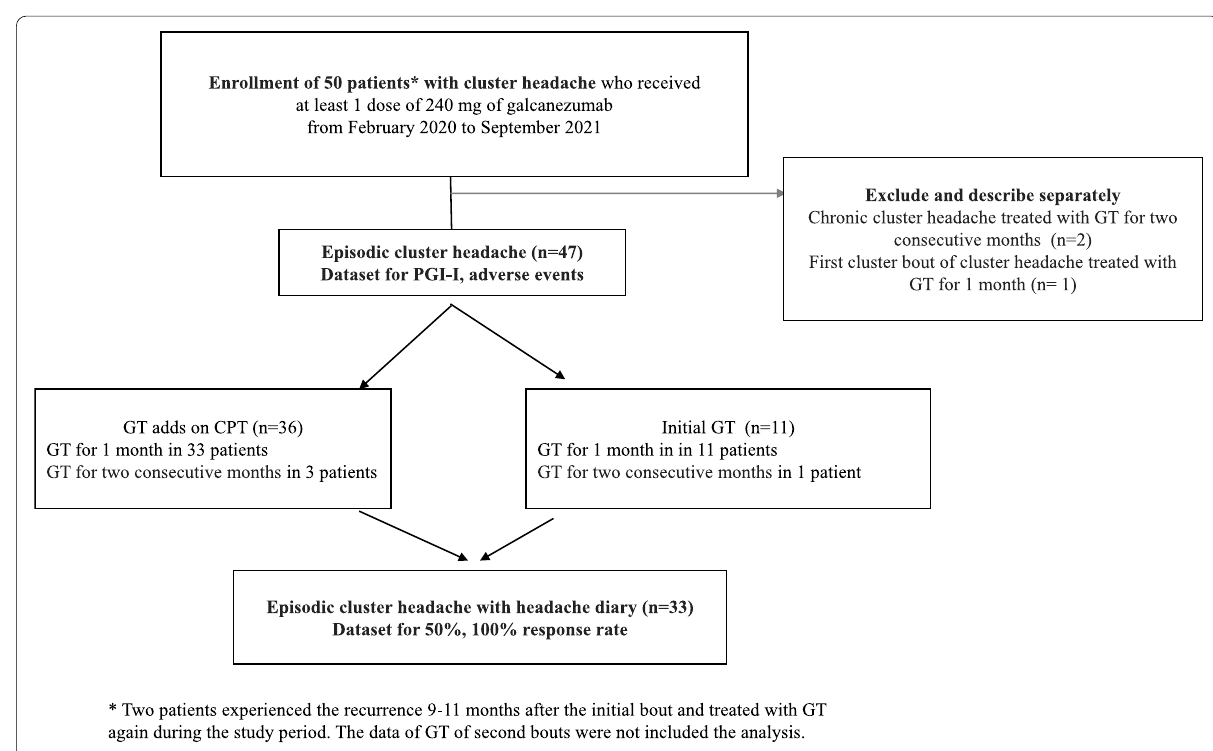
Fig. 1 Selection of patients with cluster headache. GT galcanezumab therapy, CPT conventional preventive therapy, PGI‑I, Patient global impression of